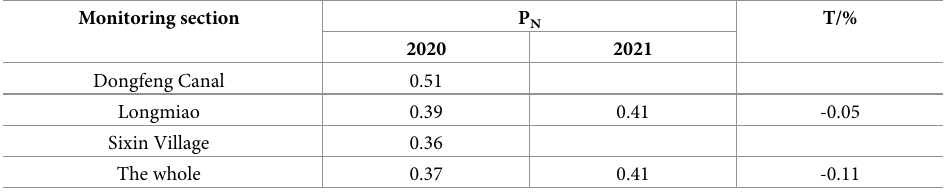
Table 8. Temporal and spatial changes of water quality in each monitoring section ofHeilongtan Reservoir from 2020 to 2021. Monitoring